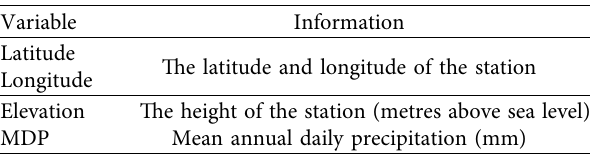
Figure 1: Geographical locations of stations in East Nusa Tenggara province. Table 1: Variables used in the clustering analysis to find the ho- mogeneous